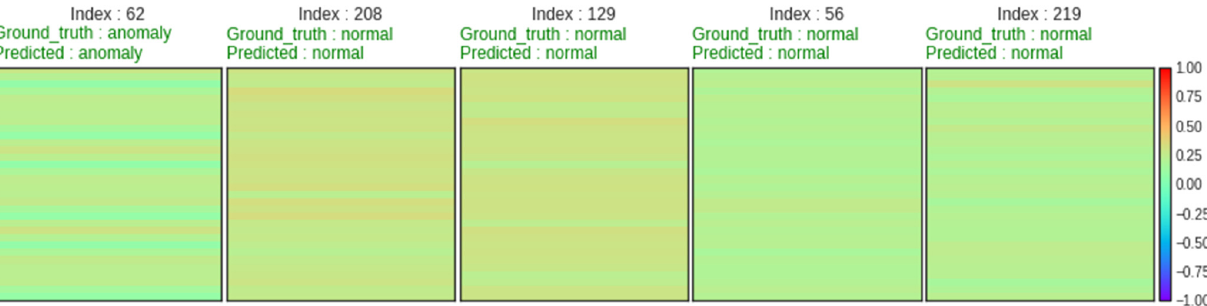
Figure 5. Slide rail data (4 K) Hilbert transform image encoding.